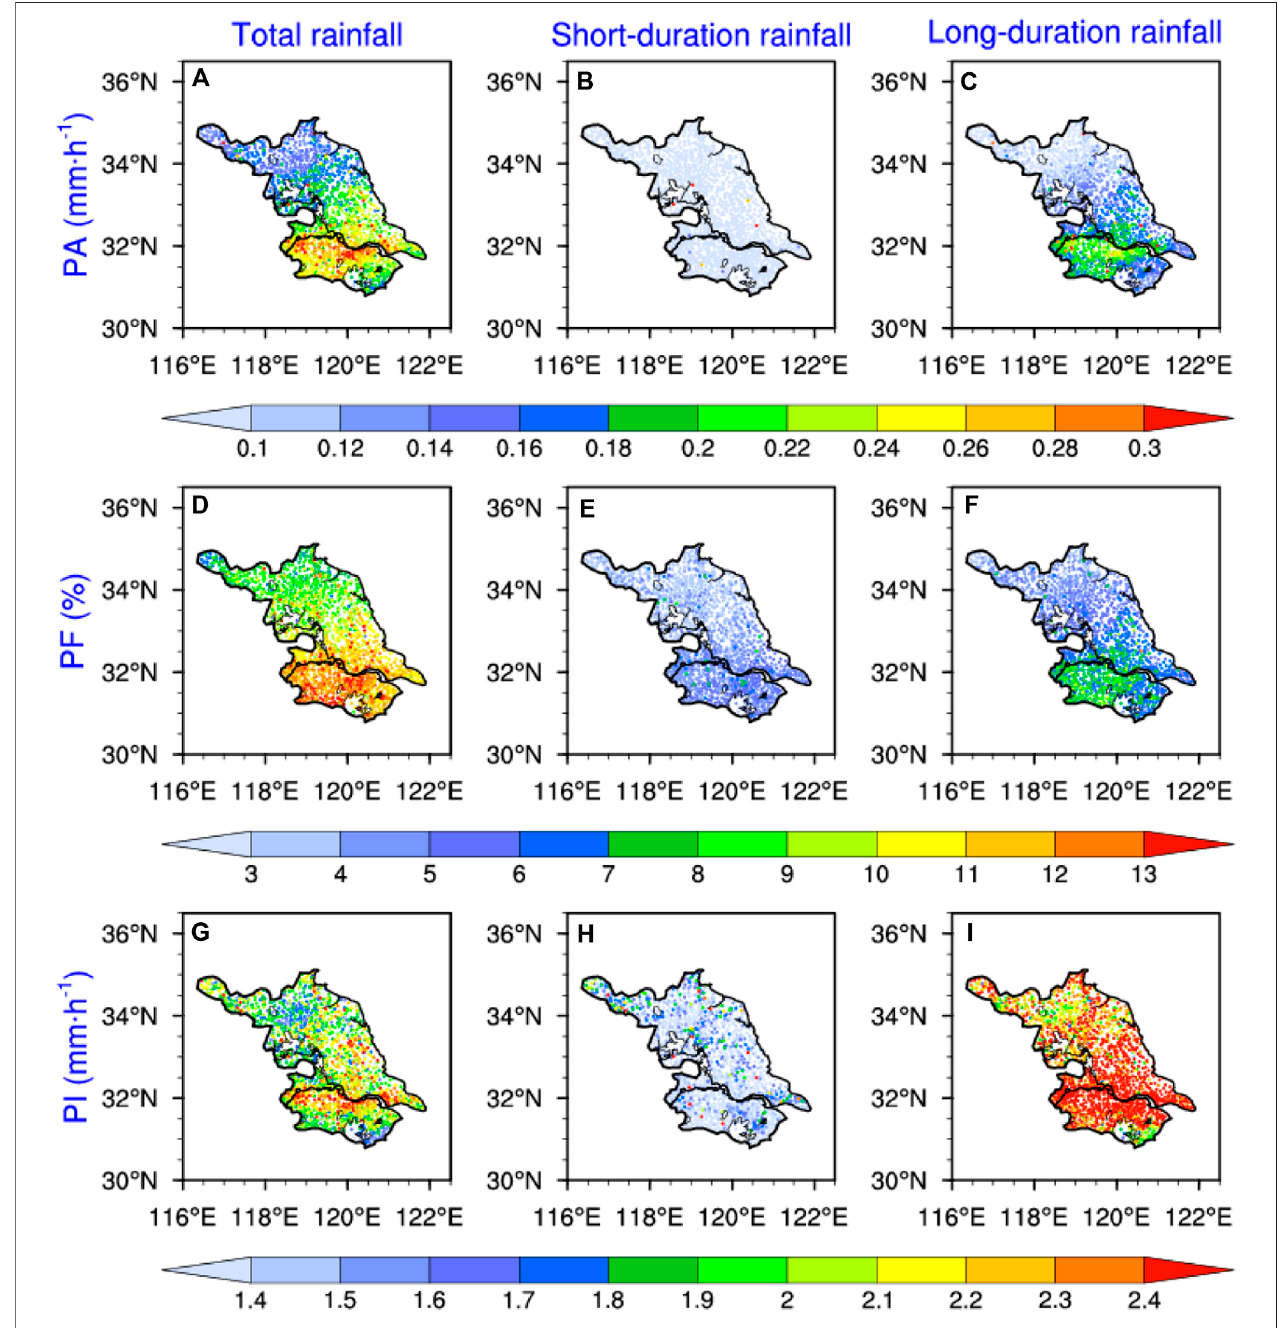
FIGURE 2 | Spatial distributions of PA (A-C) , PF (D-F) and PI (G-I) for the rainfall with different duration time in warm season (three columns separately represent total rainfall, short-duration rainfall and long-duration rainfall) averaged over 2013 – 2017.